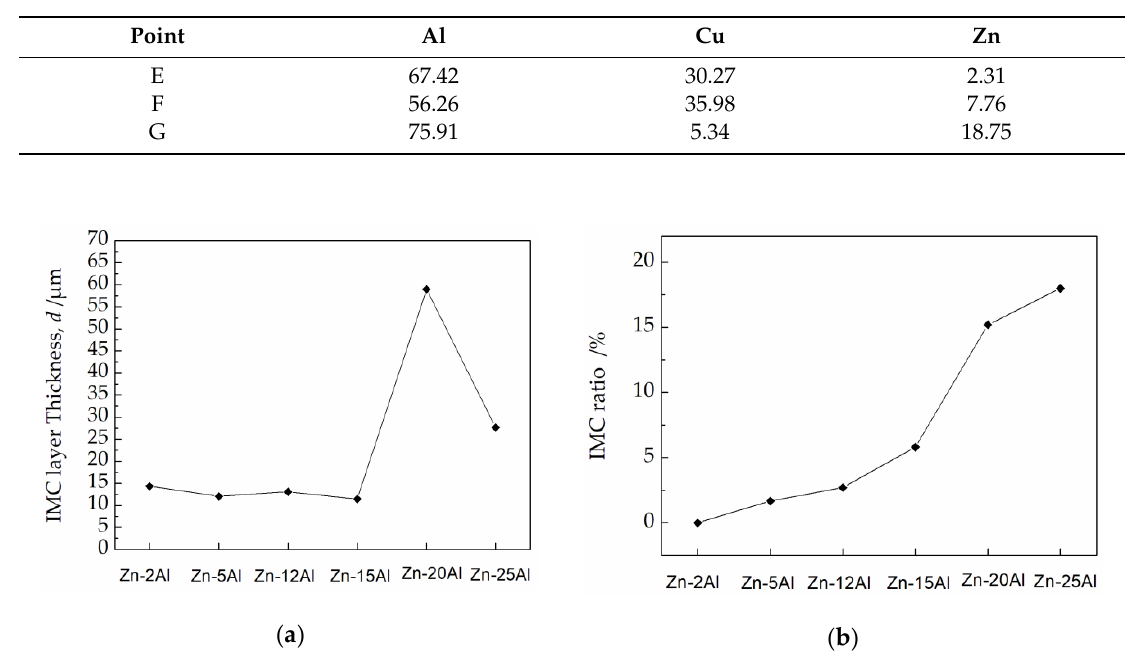
Figure 15. Changes of ( a ) IMC layer thickness and ( b ) bulk IMC ratio in Figure 13.